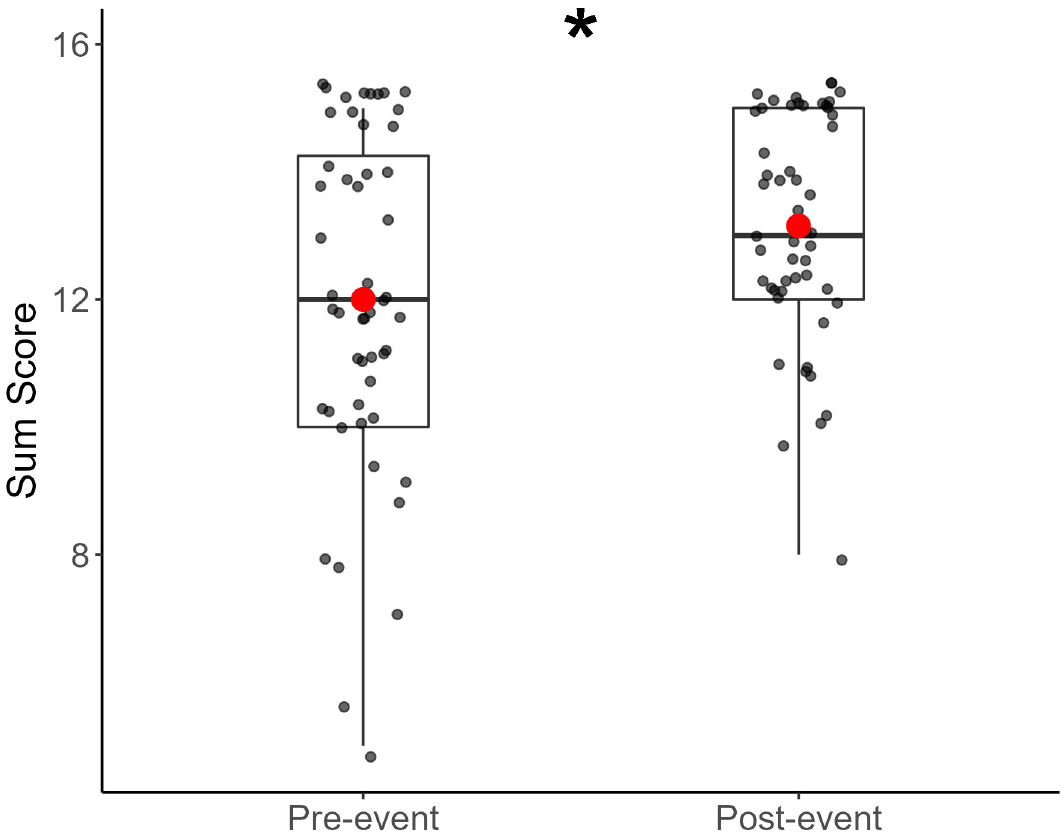
Fig 2. Boxplot of Pre- and Post-QOL sum scores. Points show individual participant data, jittered for clarity. Red dots represent means. Asterisks represent significant differences between pre- and post-survey